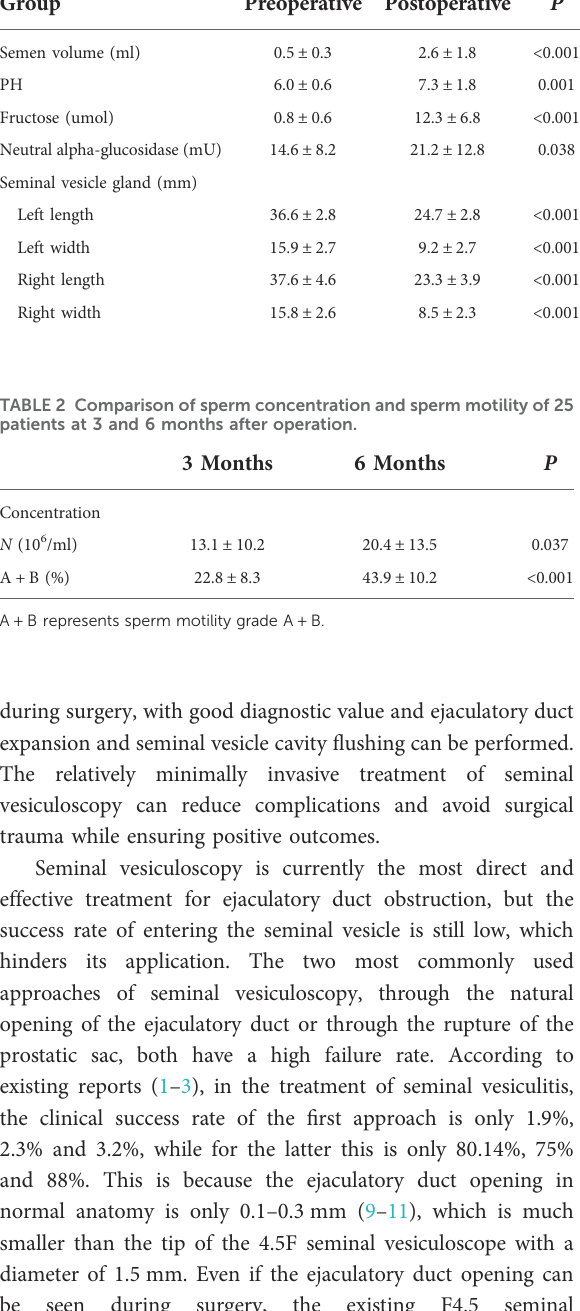
TABLE 1 Comparison of seminal plasma biochemistry and seminal vesicle gland morphology of 25 patients before and 3 months after operation.